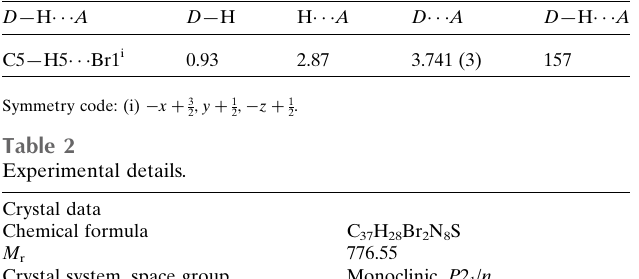
Table 1 Hydrogen-bond geometry (A˚ , (cid:2) ).